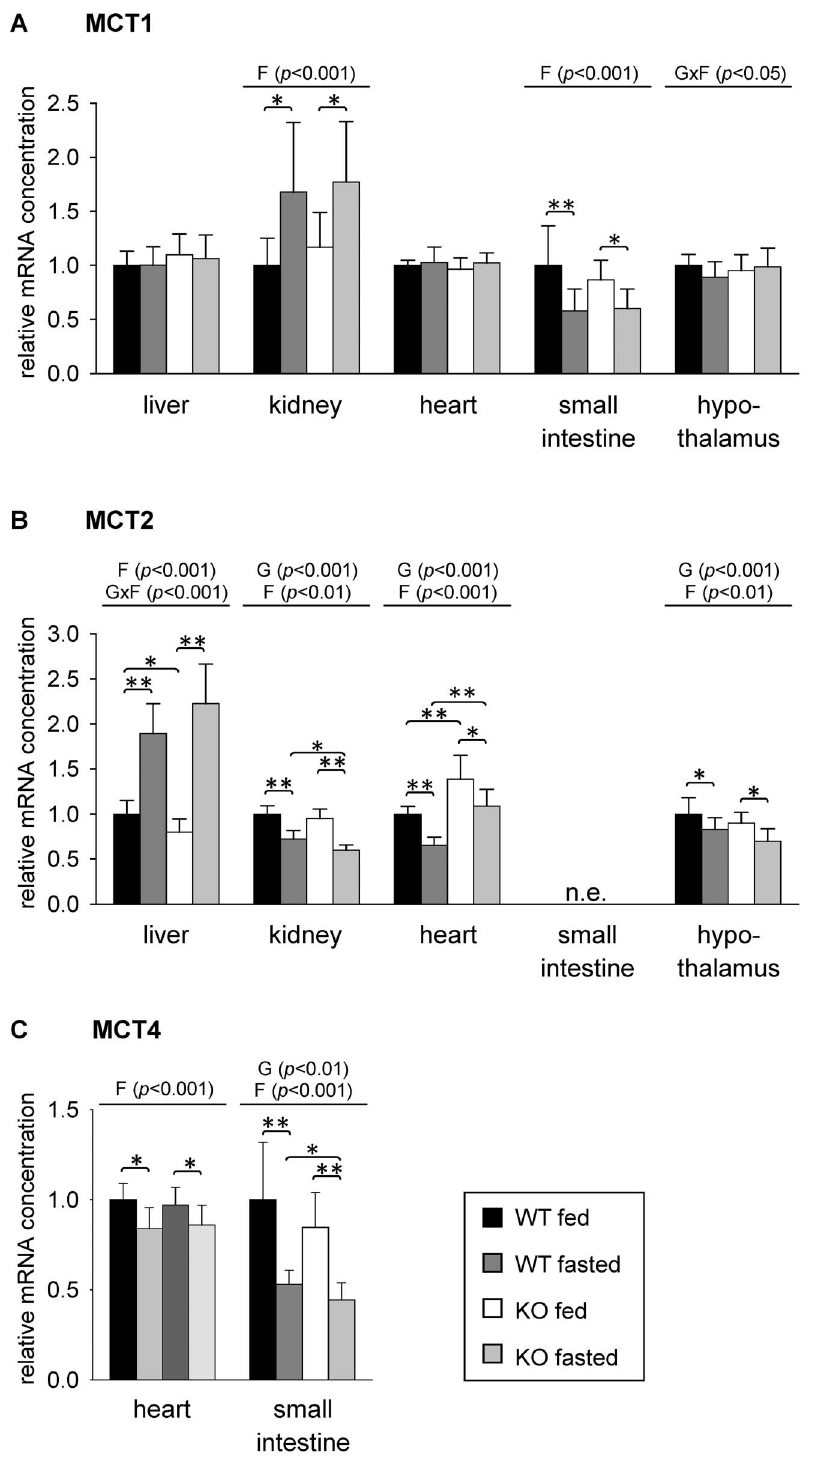
Figure 3. Relative mRNA concentrations of (A) monocarboxylate transporter (MCT)-1, (B) MCT2 and (C) MCT4 in mouse tissues in response to fasting and PPAR a . Values represent means 6 SD of relative mRNA concentrations of wildtype (WT) and PPAR a knockout (KO) mice that were fed ad libitum or fasted for 48 h (n=16). Data were analyzed by two-way ANOVA. Classification factors were genotype, fasting, and the interaction between both factors. P -values revealed by two-way ANOVA are noted above the figures. Individual means of the treatment groups were compared by Tukey’s test in case of variance homogeneity. In case of variance heterogeneity, as revealed by Levene’s test, individual means were compared by Games Howell test. Horizontal brackets represent differences between groups in post-hoc comparison (** p , 0.001, * p , 0.05). n.e., not evaluable due to extremely low expression.